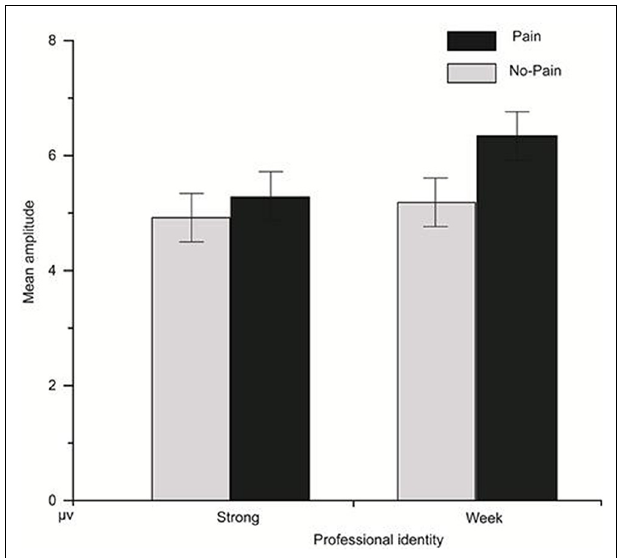
FIGURE 3 | Interaction effect of professional identity and pain empathy for the P300 component.